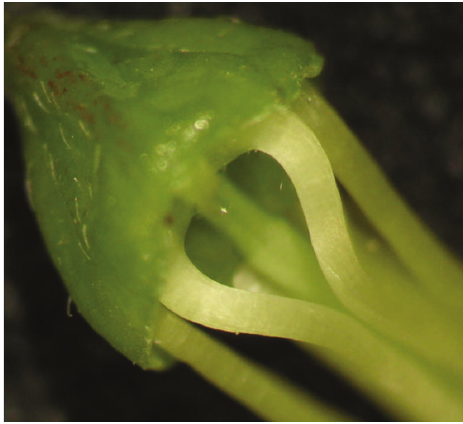
Figure 4: Flower base of C. emerus with the nectary. Two small fenestrae are evident between the joined and the free